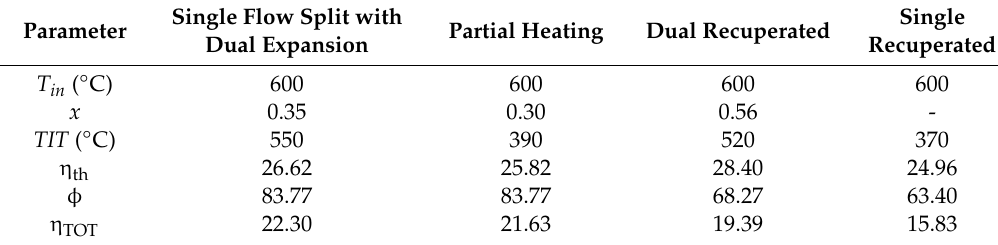
Table 8. Optimum values of the decision variables and performance metrics for the three novel s-CO 2 cycles considered in this study compared to those of the single recuperated cycle used as the baseline.